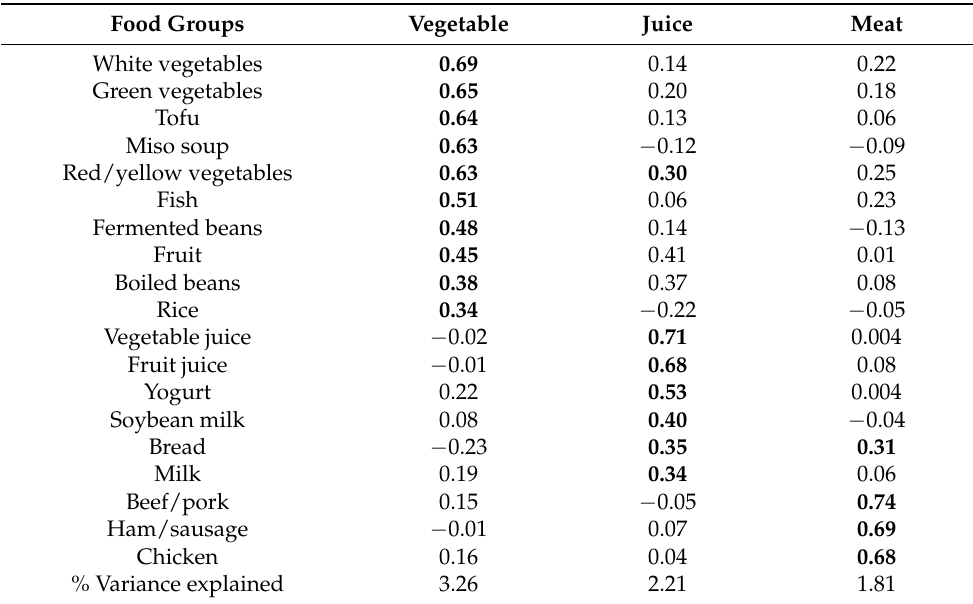
Table 1. Factor loadings of dietary patterns identified by principal component method of factor analysis, FHMS, 2011 ( n = 14,732).